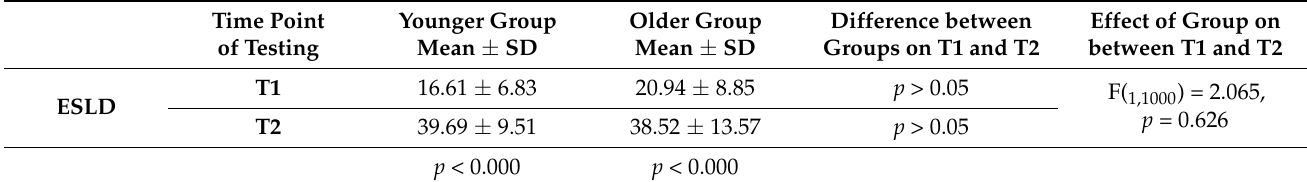
Table A2. Results of the ESLD at the first and second